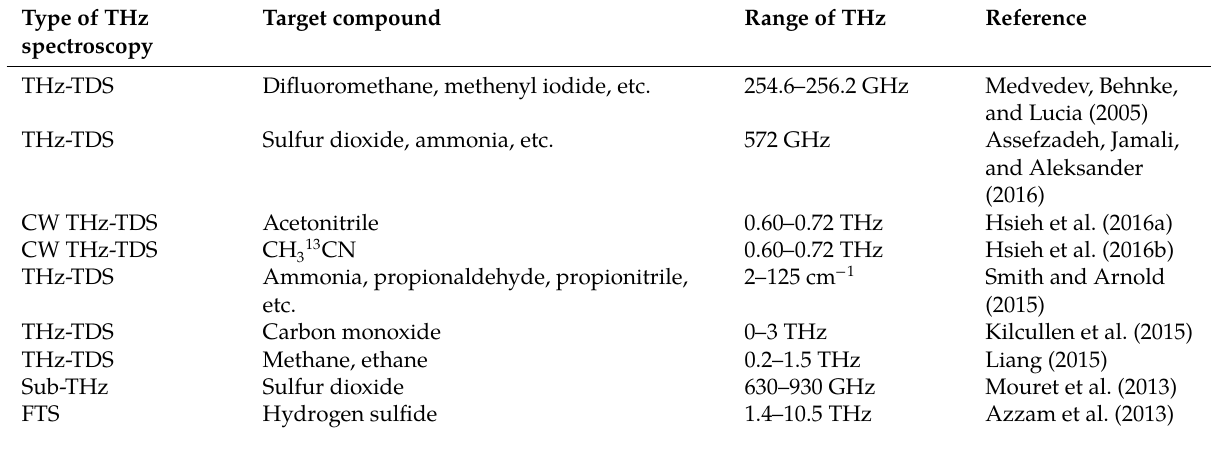
Table 1: List of toxic chemical compounds detected by THz spectroscopy. Type of